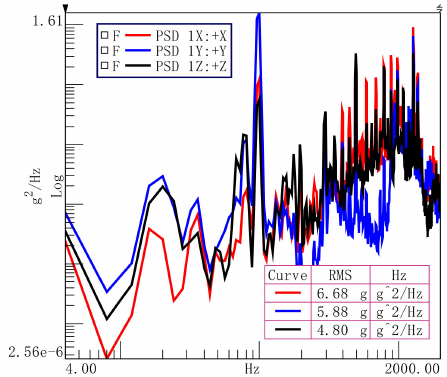
Figure 13. Vibration input PSD curve.